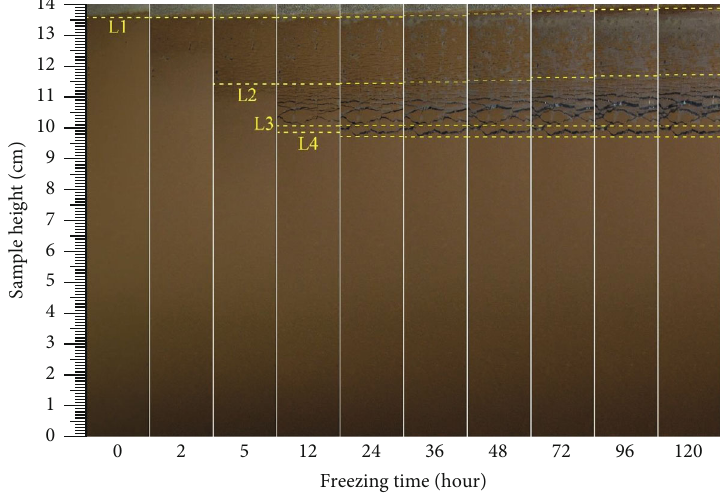
Figure 5: The cryostructure in the vertical pro fi le of the sample